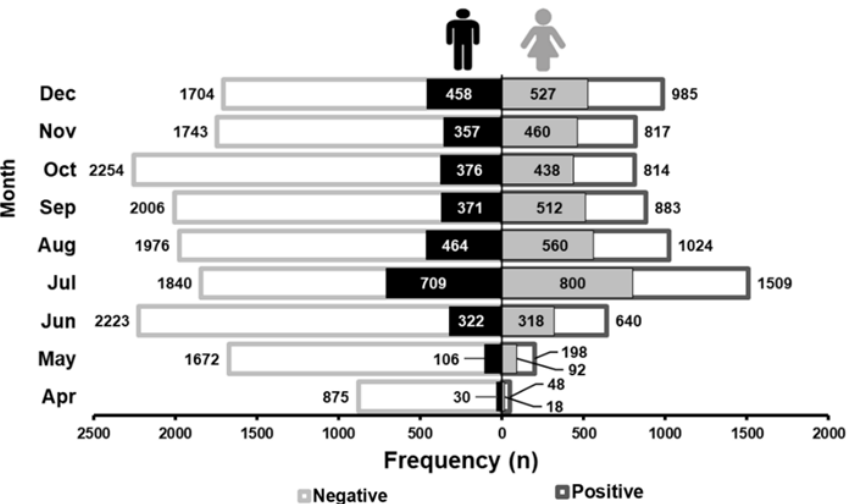
Figure 2. Total of the studied population segregated by sex and molecular SARS-CoV-2 result. The frequency in confirmed cases was increased during Mexican vacation periods (July and December). Number of men and women confirmed cases are shown in black and light gray, respectively. Total frequency of negative and positive cases is shown on the left and right edges, respectively. Table 2. Reported symptoms from people assisting to monitoring diagnosis center for molecular SARS-CoV-2 testing; all individual symptoms and lack of symptoms (asymptomatic) are